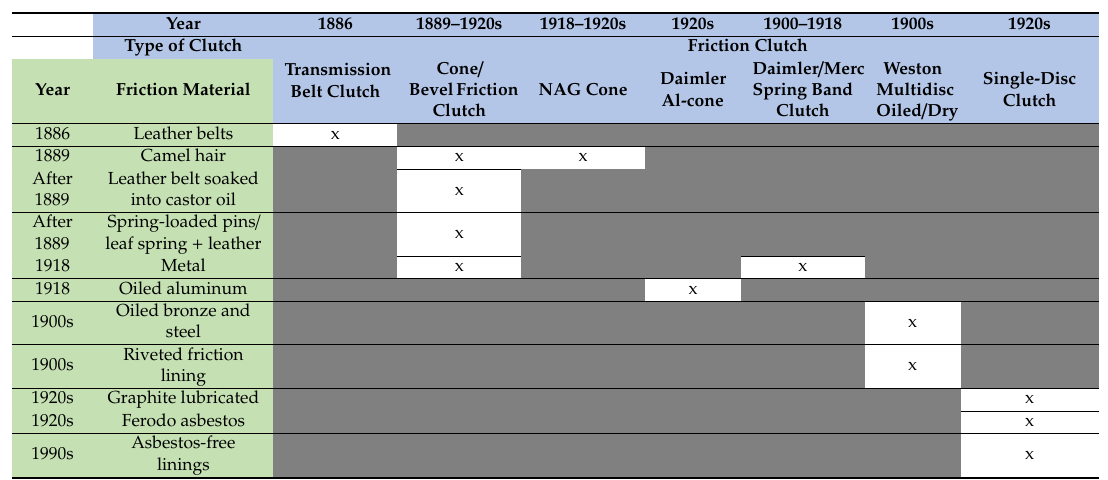
Table 1. Clutch friction materials vs. constructions (adapted from